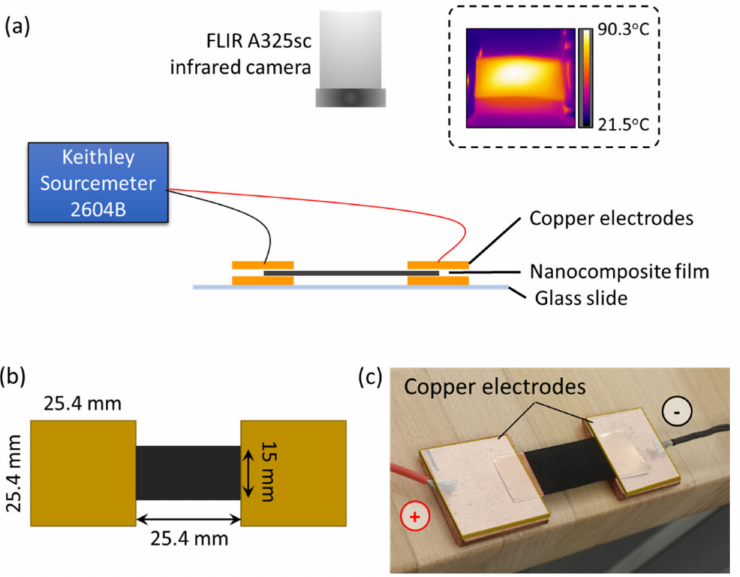
Figure 1. ( a ) Overall setup used for electrical conductivity and Joule heating measurements. Inset shows representative 2D temperature plot recorded with infrared camera at 10 V for a 0.50 mm-thick 20 wt.% MWCNT/PP film after approximately 1 min; ( b ) copper electrodes and nanocomposite film dimensions; ( c ) example of actual nanocomposite film and electrodes placement. Dimensions are not to